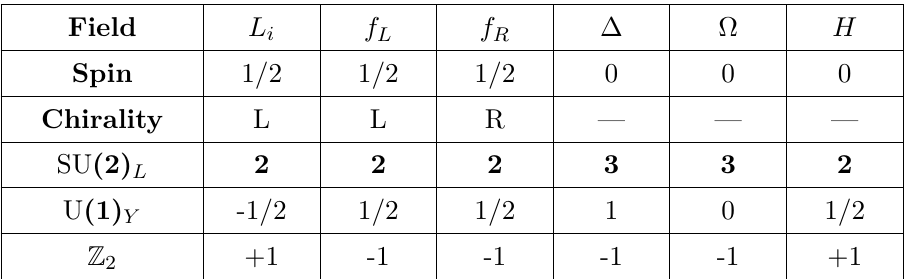
Table 1 . Charge assignment of the new fields considered in this model in addition to the SM i − th flavour lepton doublet L i and SM Higgs doublet H